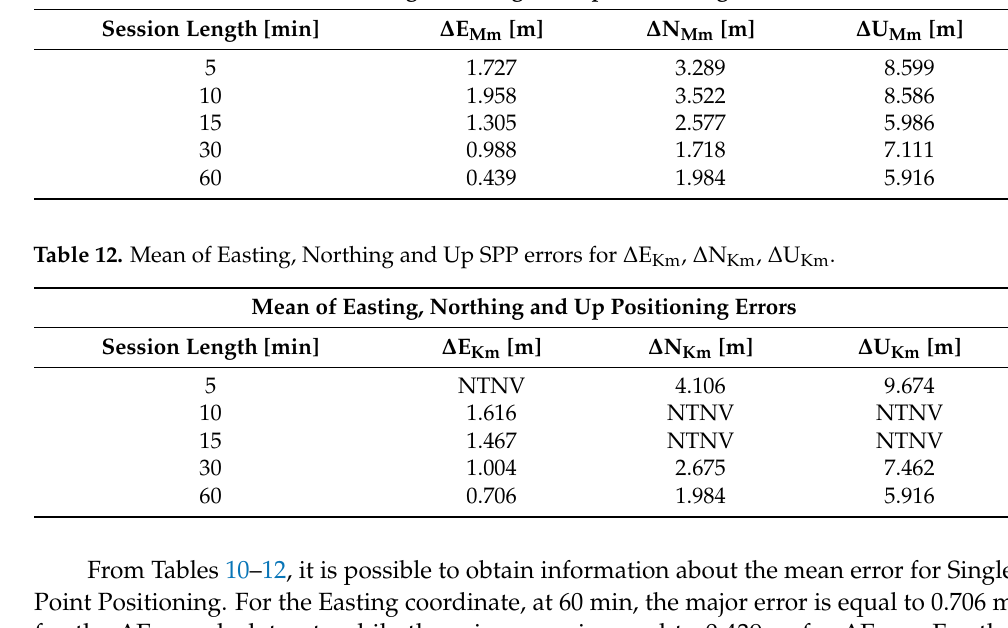
Table 11. Mean of Easting, Northing and Up SPP errors for ∆ E Mm , ∆ N Mm , ∆ U Mm . Mean of Easting, Northing and Up Positioning Errors